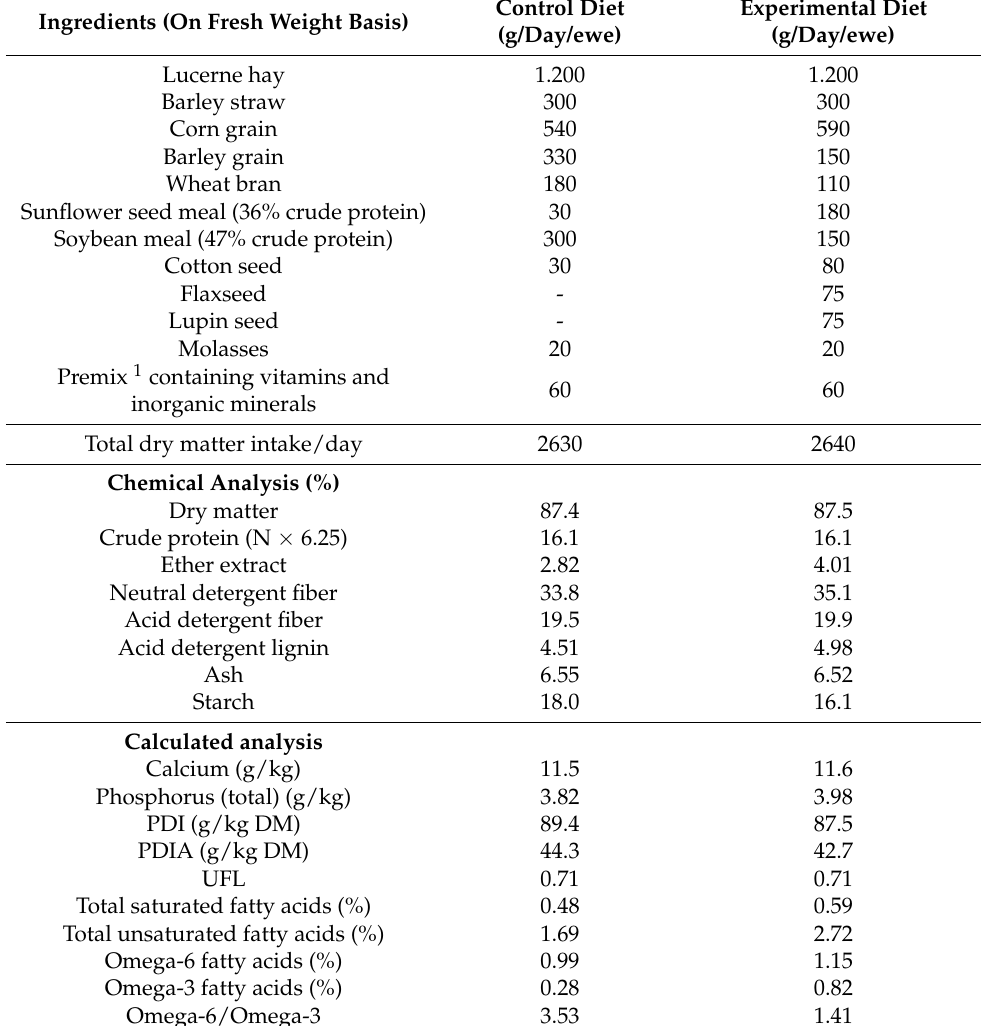
Table 1. Daily ingredient allowance and chemical composition of the diets offered to dairy ewes during the